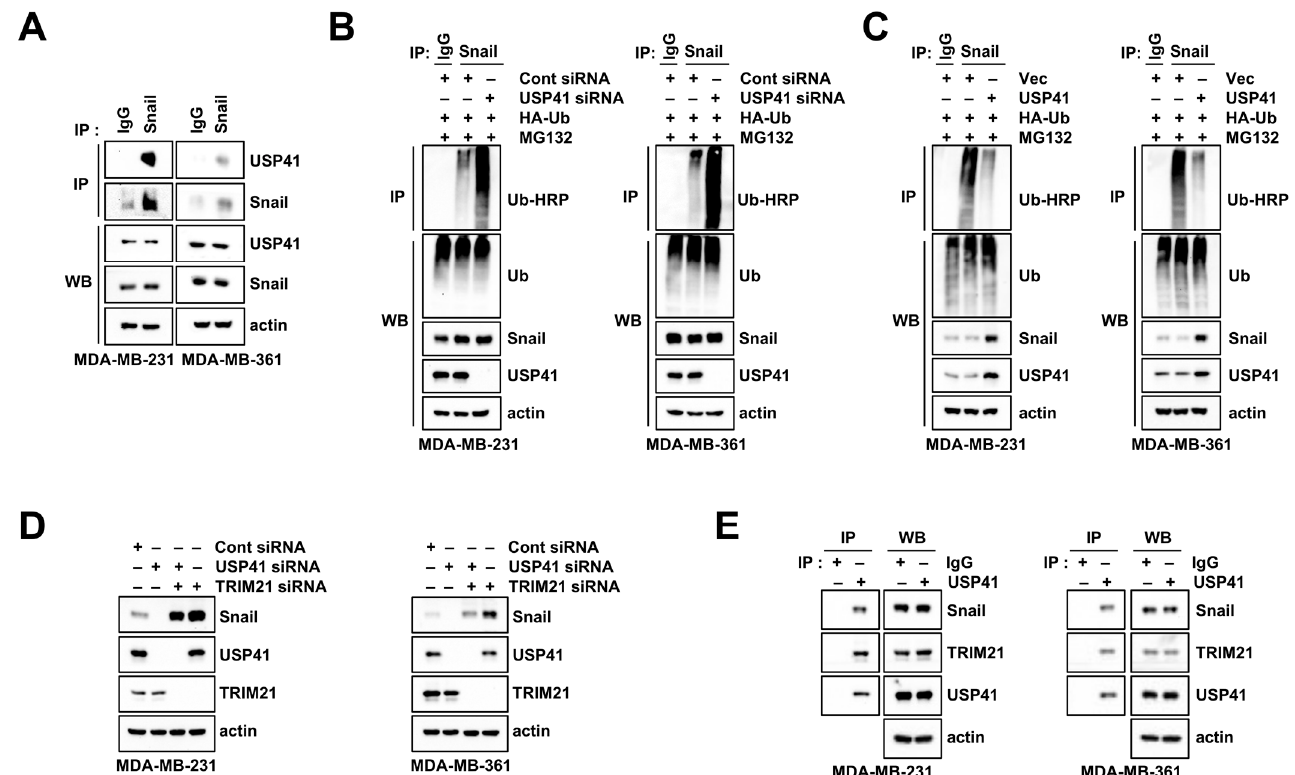
Figure 5. USP41 interacts and deubiquitylates with Snail. ( A ) Interaction between endogenous USP41 and Snail was examined by immunoprecipitation (IP) assay. ( B , C ) MDA ‐ MB ‐ 231 and MDA ‐ MB ‐ 361 cells were co ‐ transfected with Cont and USP41 siRNA ( B ) or vector and USP41 ( C ) with HA ‐ Ub plasmid, and treated with 0.25 μ M MG132 for 24 h. ( D ) MDA ‐ MB ‐ 231 and MDA ‐ MB ‐ 361 cells were transfected with Cont, USP41, or/and TRIM21 siRNA for 48 h. ( E ) Interaction between endogenous Snail or TRIM21 with USP41 was examined by IP assay. IP ( A , E ) and ubiquitination ( B , C ) were detected by Western blotting. Protein expression was determined by Western blotting ( D ).